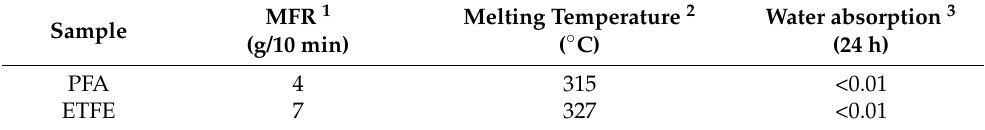
Table 1. Properties of commercial ETFE